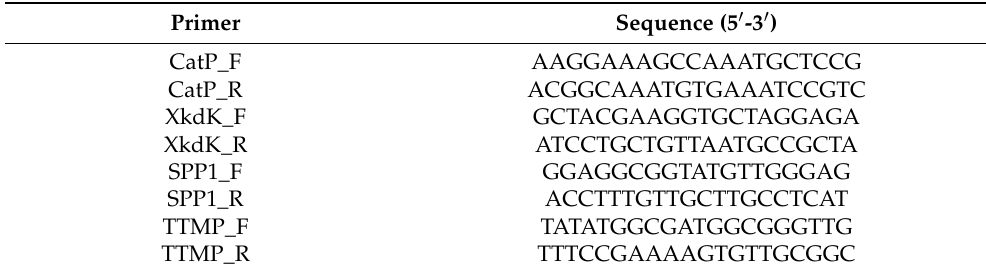
Table 2. Primers used for CatP, XkdK, SPP1, and TTMP amplification.